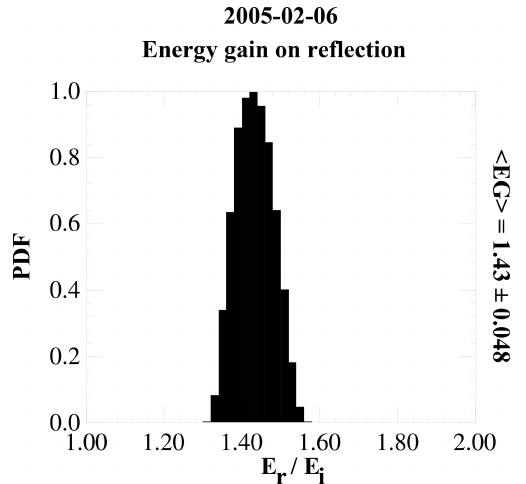
Figure 9. PDF plot of the energy gain on reflection from the bow shock. The PDF was formed from the results of the energization model by varying the shock normal and magnetic field components within a 1 σ band about their average values. The average energiza- tion and the 1 σ value are shown to the right of the plot.